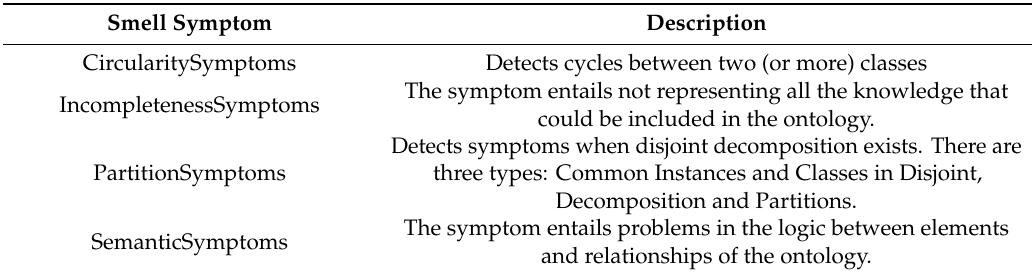
Smell Symptoms (“ONTOLOGICAL ERRORS—Inconsistency, Incompleteness, and Redundancy”